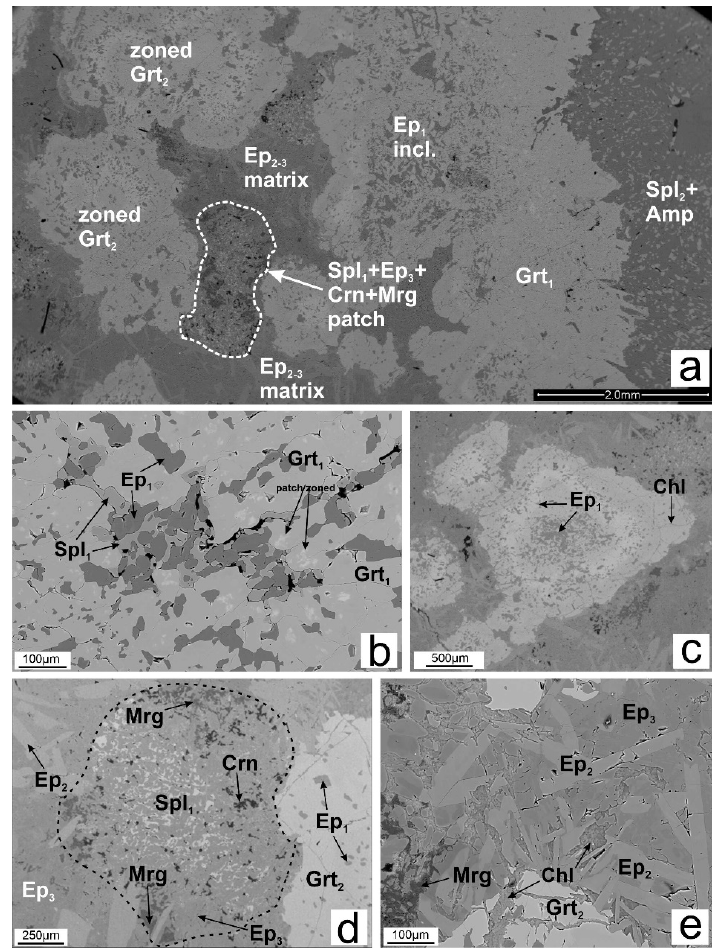
Figure 4. Back-scattered electron (BSE) images of the most relevant microstructures of garnet-rich veins (composite) from ultrabasic amphibolites of Mt. Nieddu: ( a ) General overview of a garnet vein section from core (left side of the photo) to rim (right side of the photo); ( b ) Detail of an association between epidote and spinel in the garnet coat (Grt1); ( c ) Overview of a zoned garnet porphyroblast inside the core of the vein; it contains several epidote inclusions; ( d ) Detail of a sub-rounded patch in the epidote matrix; ( e ) Detail of the epidote matrix. Grt = garnet; Spl = Spinel; Amp = amphibole; Ep = epidote; Crn = corundum; Mrg = margarite; Chl =